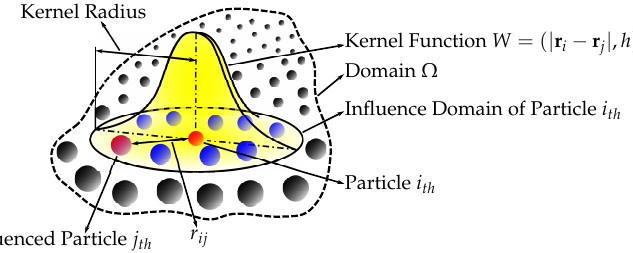
Figure 3. Smoothed-Particle Hydrodynamics Kernel